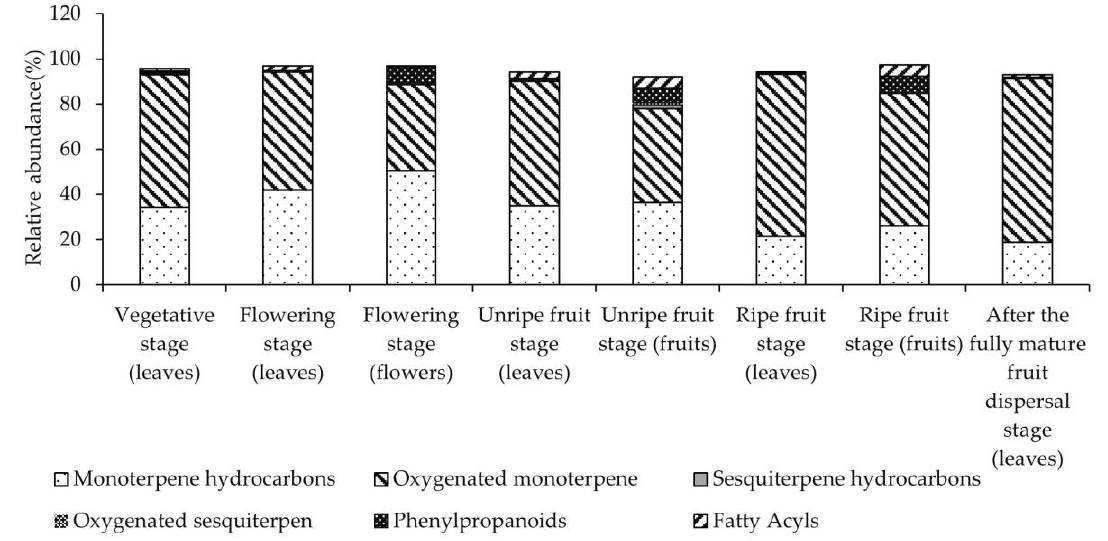
Figure 3. Comparison of main chemical groups (%) of myrtle organs in different phenological